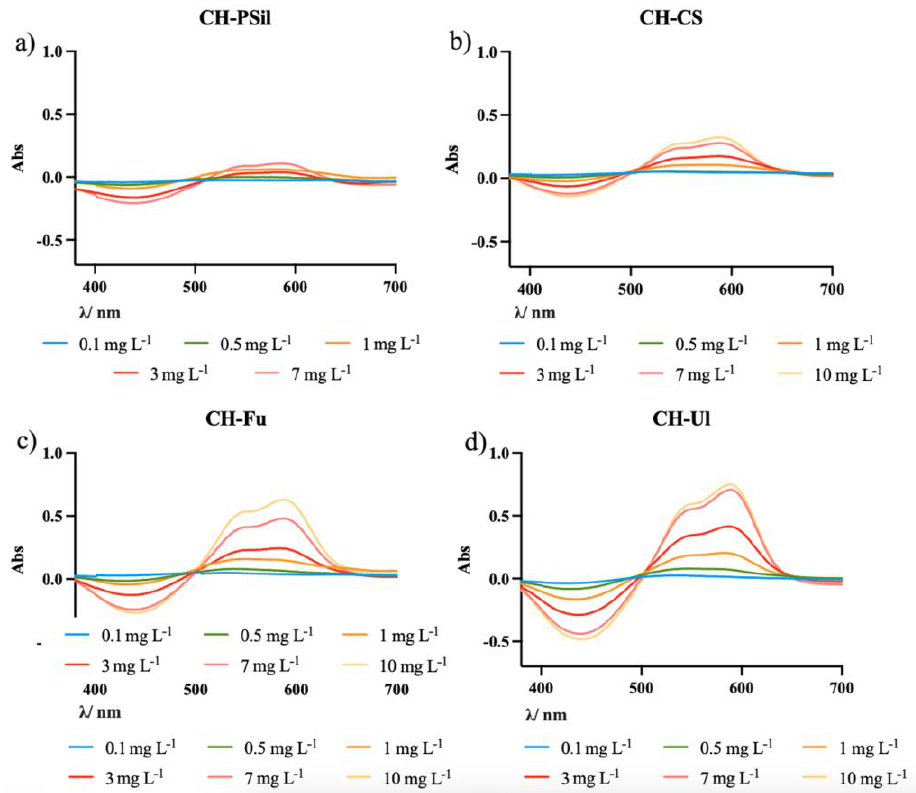
Figure 4. Graphical representation of absorption spectra for the different types of sensing membranes in solutions with different Al(III) concentrations: ( a ) CH-PSil; ( b ) CH-CS; ( c ) CH-Fu; ( d ) CH-Ul